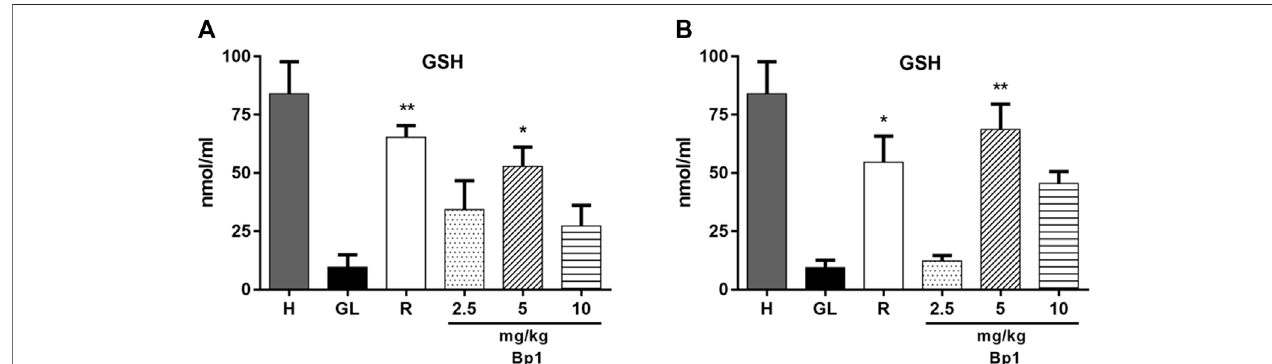
FIGURE 11 | Effect of pretreatment with Bp1 (2.5, 5, and 10 mg/kg) on GSH levels in the gastric mucosa homogenate of lesions in mice (A) ethanol-induced and (B) indomethacin-induced.Resultsexpressedasmean ± standardmeanerror( n (cid:2) 7).ANOVAandTukeypost-testwereusedtocalculatethestatisticalsigni fi cance,* p < 0.05 and ** p < 0.01 vs. gastric lesion control. Healthy, H; gastric lesion control, GL; ranitidine (50 mg/kg), R.